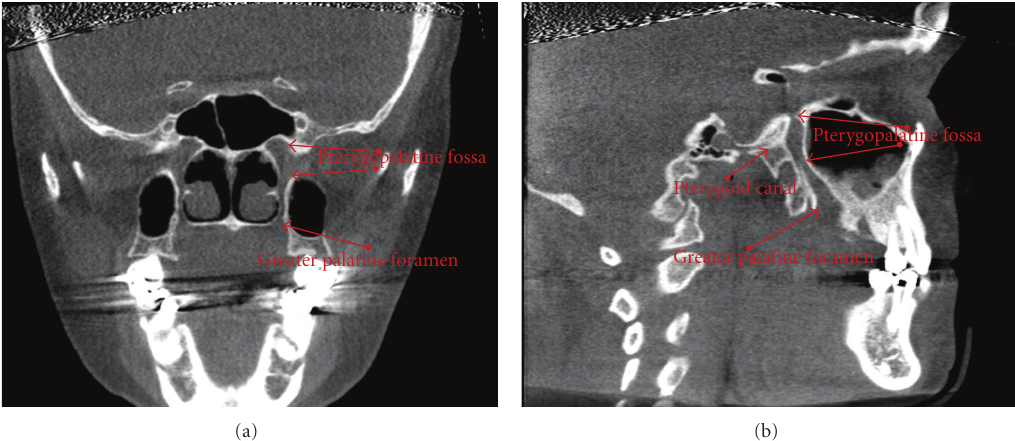
Figure 1: The images above demonstrate the appearance of anatomical structures on CBCT images described above; coronal view (a) and sagittal view (b). From the coronal view, the pterygopalatine fossa and greater palatine canal can be seen lateral to the nasal cavity. The pterygopalatine fossa begins below the middle cranial fossa and meets the greater palatine canal below which extends to enter the hard palate at the greater palatine foramen. In the sagittal view, the pterygopalatine fossa and greater palatine canal can be seen again, posterior to the maxillary sinus. The pterygoid canal is visible here, entering the pterygopalatine fossa from the posterior. The midpoint of the pterygoid canal was determined in this plane for each canal and used as the superior point of measurement.